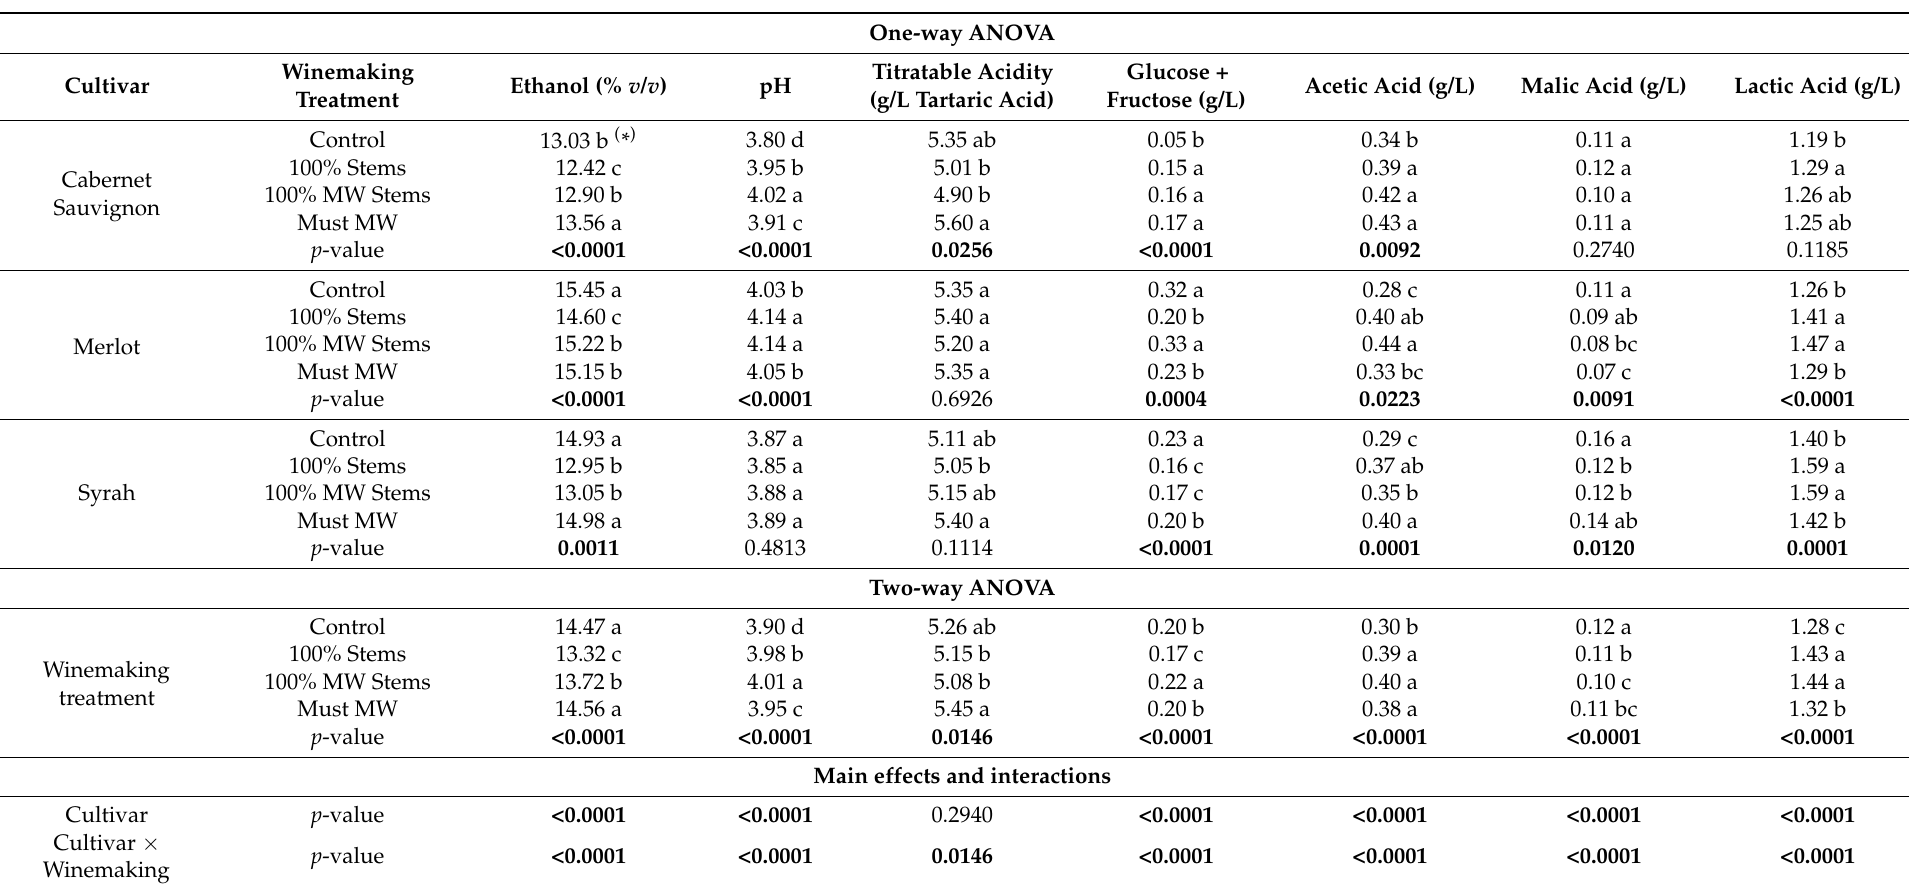
Table 3. One-way and two-way analysis of variance (ANOVA) separating the effects of cultivar and winemaking treatment on the basic chemical composition of Cabernet Sauvignon, Merlot and Syrah wines from the 2017 vintage. Values represent the mean of three tank replicates ( n =